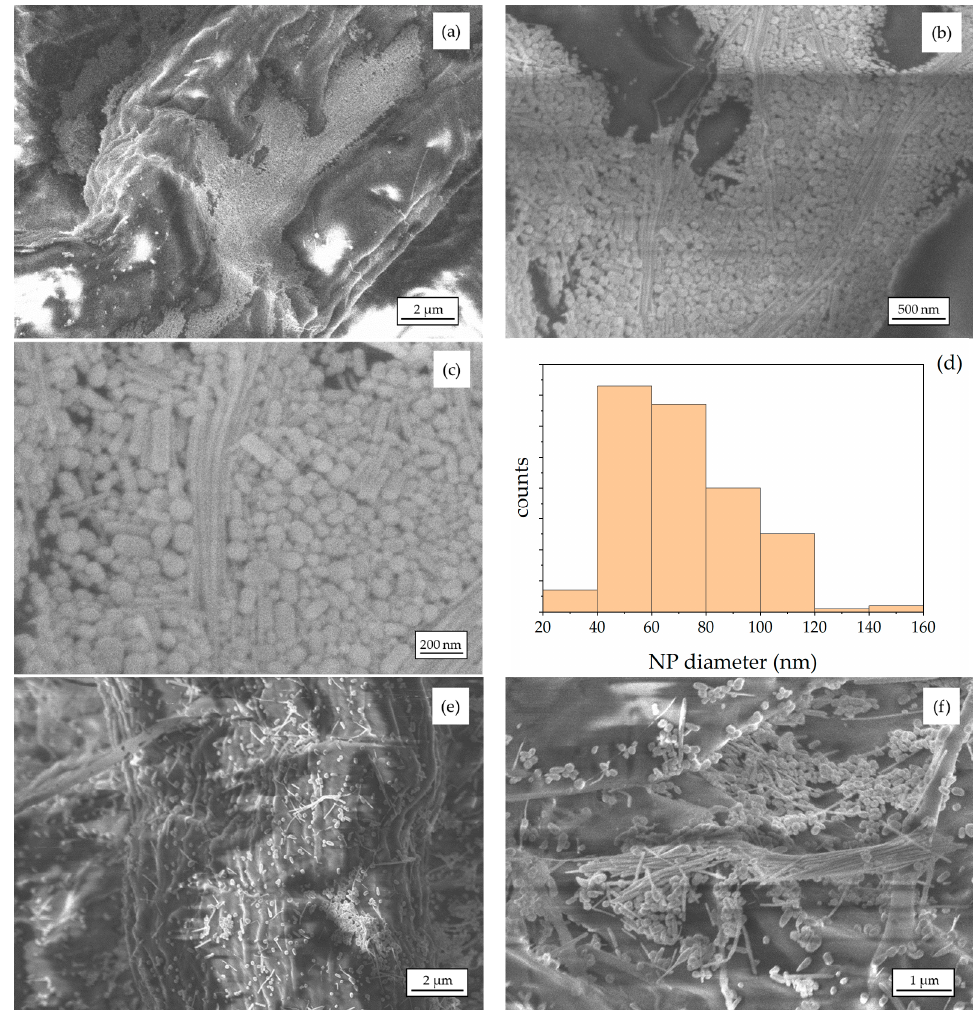
Figure 3. ( a – c ) Representative SEM micrographs of the Ag NPs and nanorods assemblies formed on the paper substrates produced by centrifugation. In ( a ), we clearly recognize one paper fiber run- ning across the diagonal of the image. High-magnification optical images (not shown here) of the ( d ) Size distribution histogram of the spherical Ag NPs sampled from image ( b ). ( e , f ) Representative